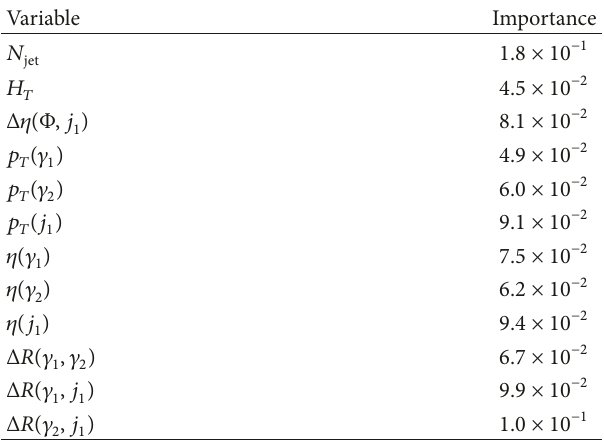
Table 2: Input variables used for MVA to separate 𝑔𝑔 and 𝛾𝛾 production modes and their relative